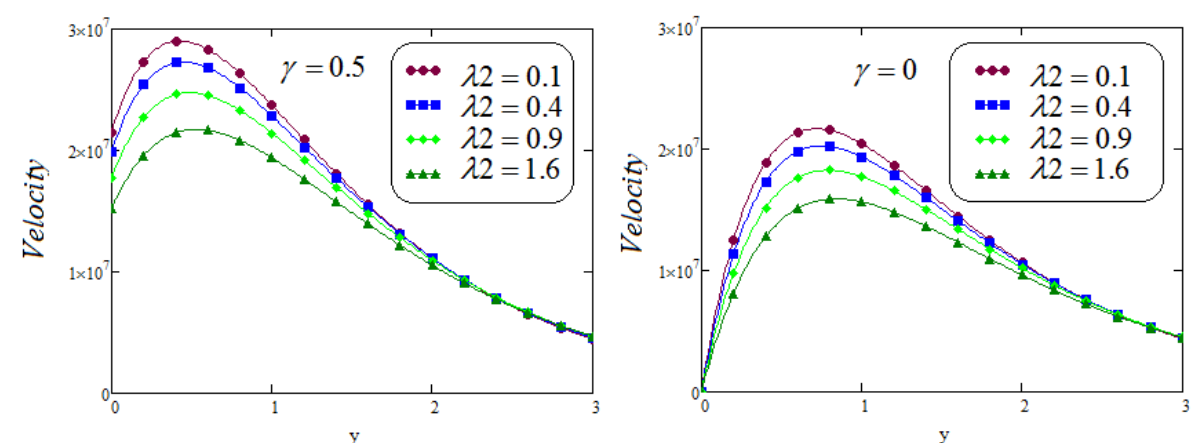
Figure 7. Velocity for varied values of λ 2 with and without slip effect γ when f ( t ) = e at , a = 0.25, t = 1.5, α = 0.5, β = 0.3, Gr = 3.5, λ 1 = 0.6, P r = 0.71, M = 2.